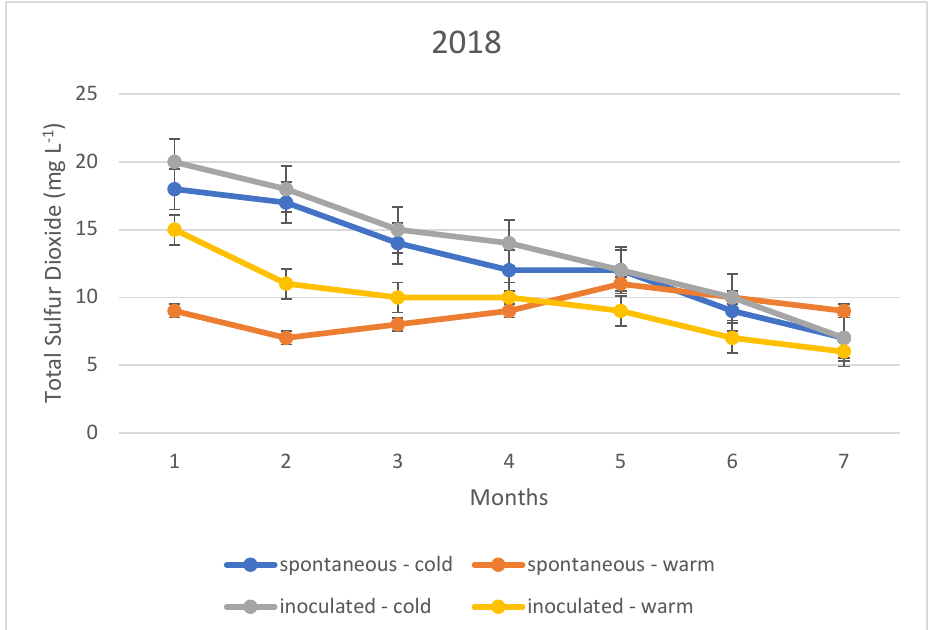
Figure 1. Total sulphur dioxide content measured during storage in 2017.